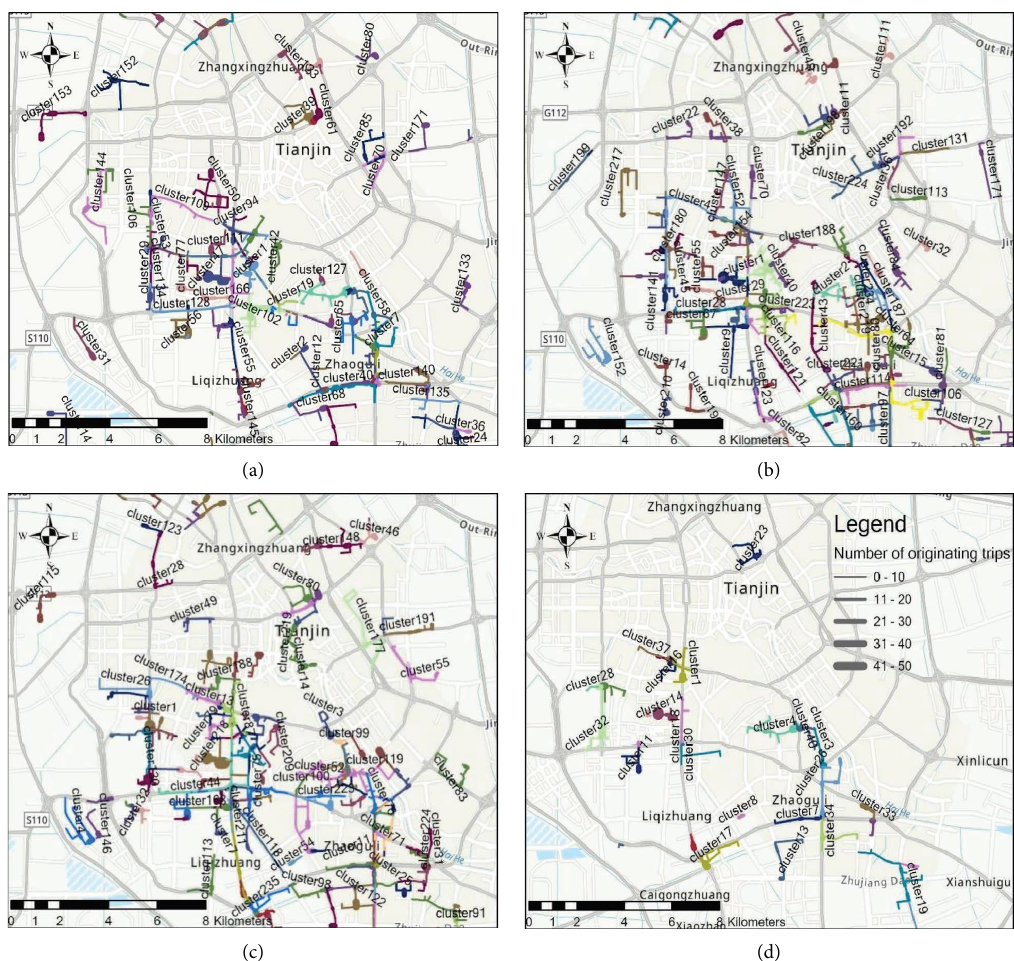
Figure 7: Path clustering results from 8:00 to 8:30 on September 10 to 13. (a) September 10 th , (b) September 11 th , (c) September 12 th , and (d) September 13th.